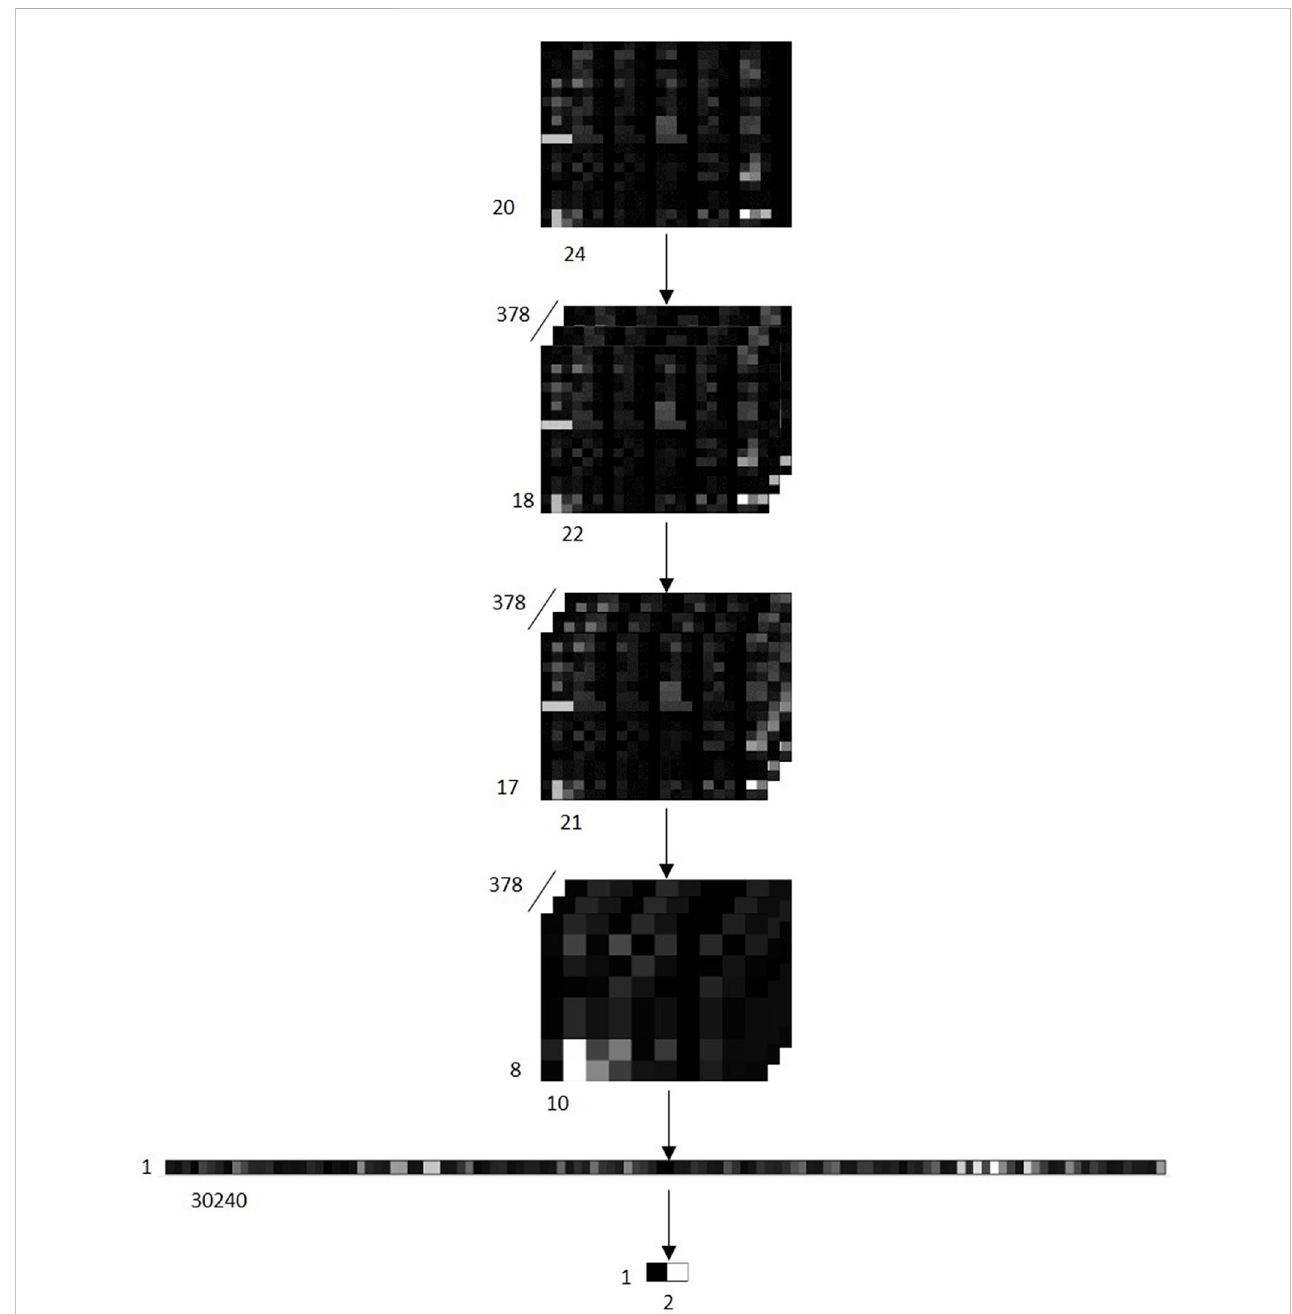
FIGURE 2 Schematic diagram of various transformations that occur after feature maps of samples are input into the CNN model. Input 378 feature maps into the CNN model. The fi rst convolution layer generates 378 [18 × 22] matrixes. The second convolution layer converts the 378 [18 × 22] matrixes into 378 [17 × 21] matrixes. Next, it is converted into 378 [8 × 10] matrixes through the maximum pooling layer, and then expand the matrix into a [1 × 30240] Vector. Finally, a [1 × 2] vector is output through a full connection layer, where 0 represents that the sample is predicted to be a negative class, and 1 represents that the sample is predicted to be a positive